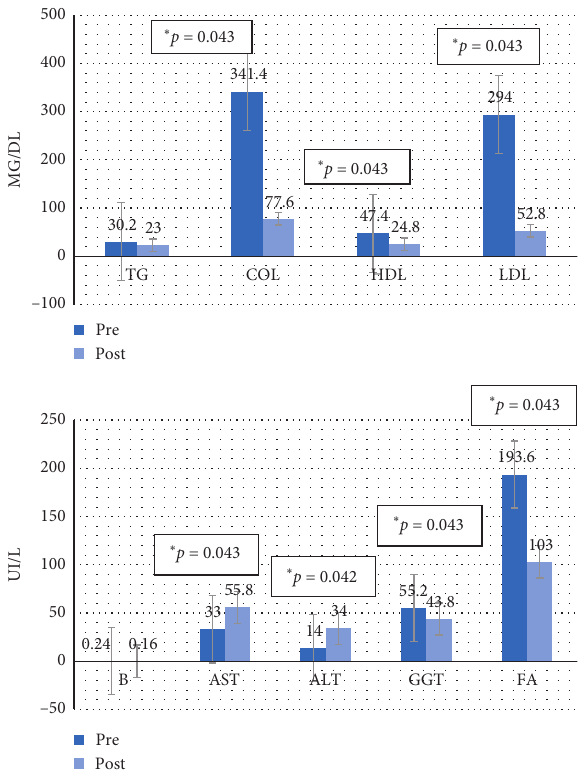
Figure 6: Average values of the pre-post parameters for group 3. TG � triglycerides, COL � total cholesterol, HDL � HDL choles- terol, LDL � LDL cholesterol, B � bilirubin, AST � aspartate ami- notransferase, ALT � alanine aminotransferase, GGT � gamma- glutamyl transferase, FA � alkaline phosphatase.